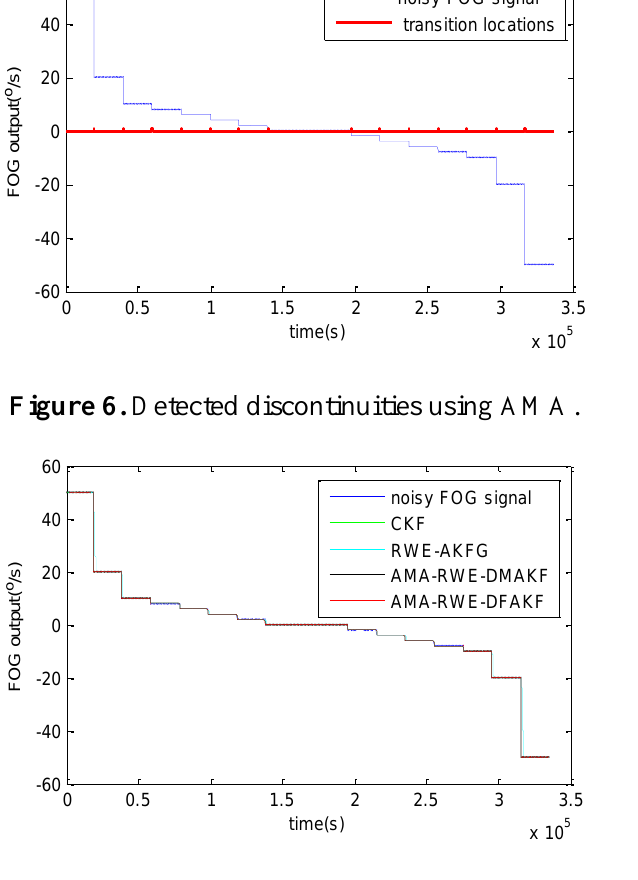
Figure 7. Denoising results of FOG dynamic signal.